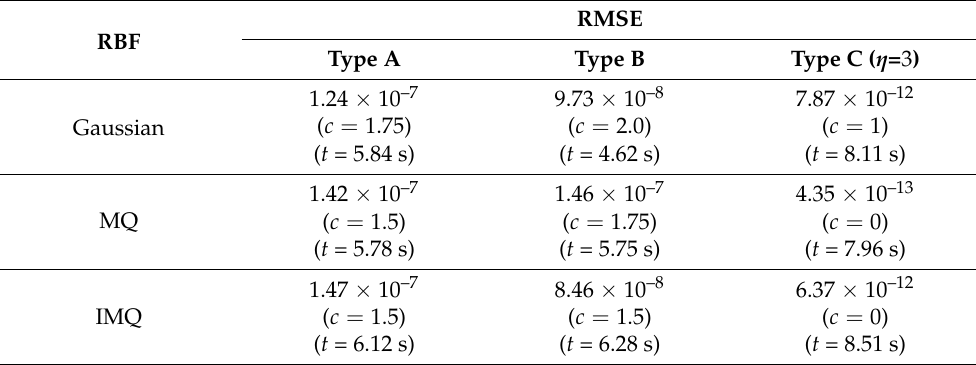
Table 2. Comparison of the results for example 1.